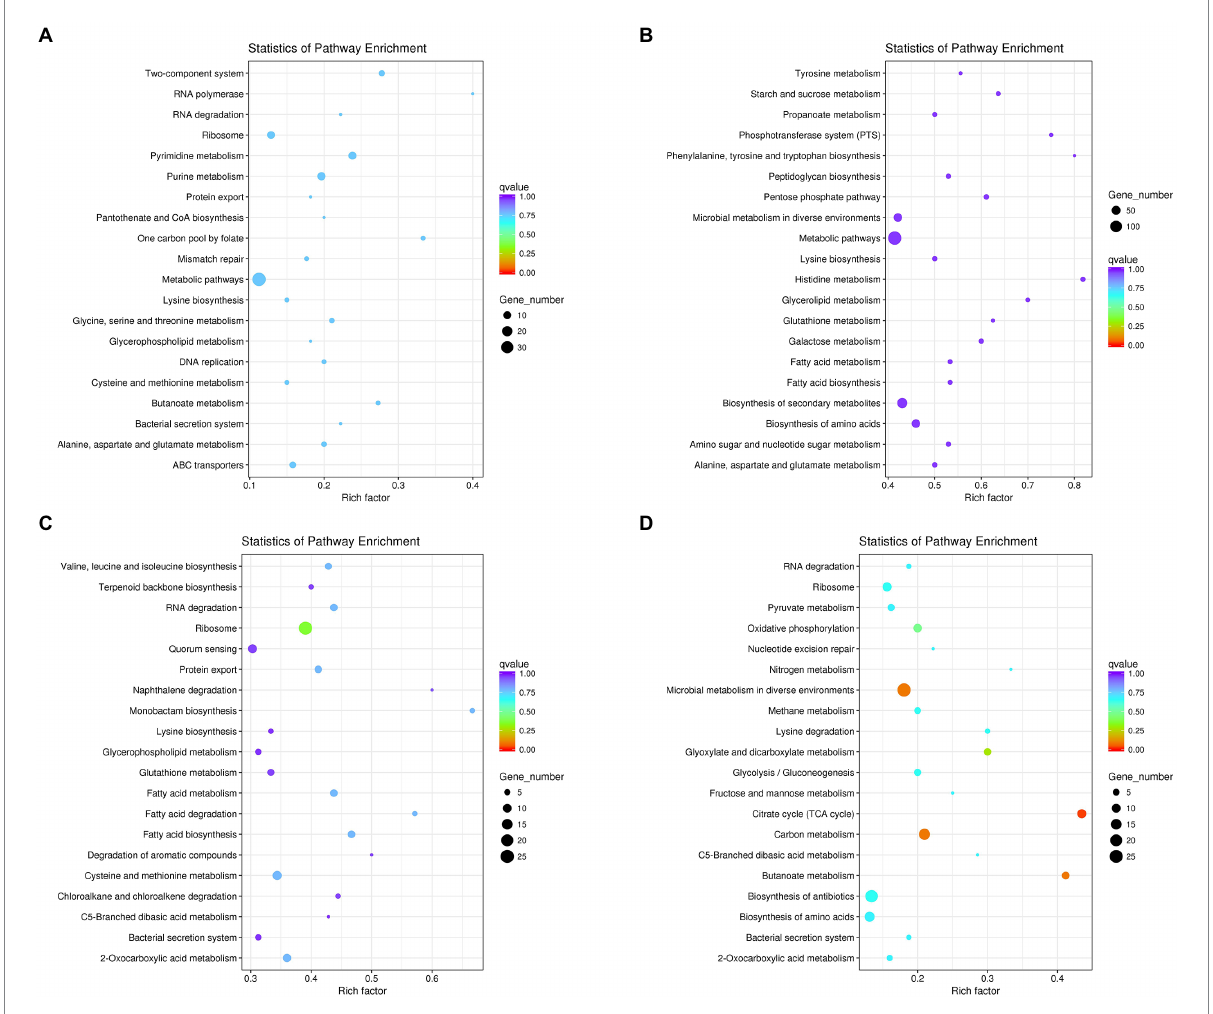
FIGURE 5 The KEGG metabolic pathway analysis of differential genes under coculture condition compared with those of mono-culture. (A) Pathway of up-regulated in L. helveticus CGMCC 12062; (B) and down-regulated; (C) Pathway of up-regulated in A. pasteurianus CGMCC 3089; (D) and down-regulated.